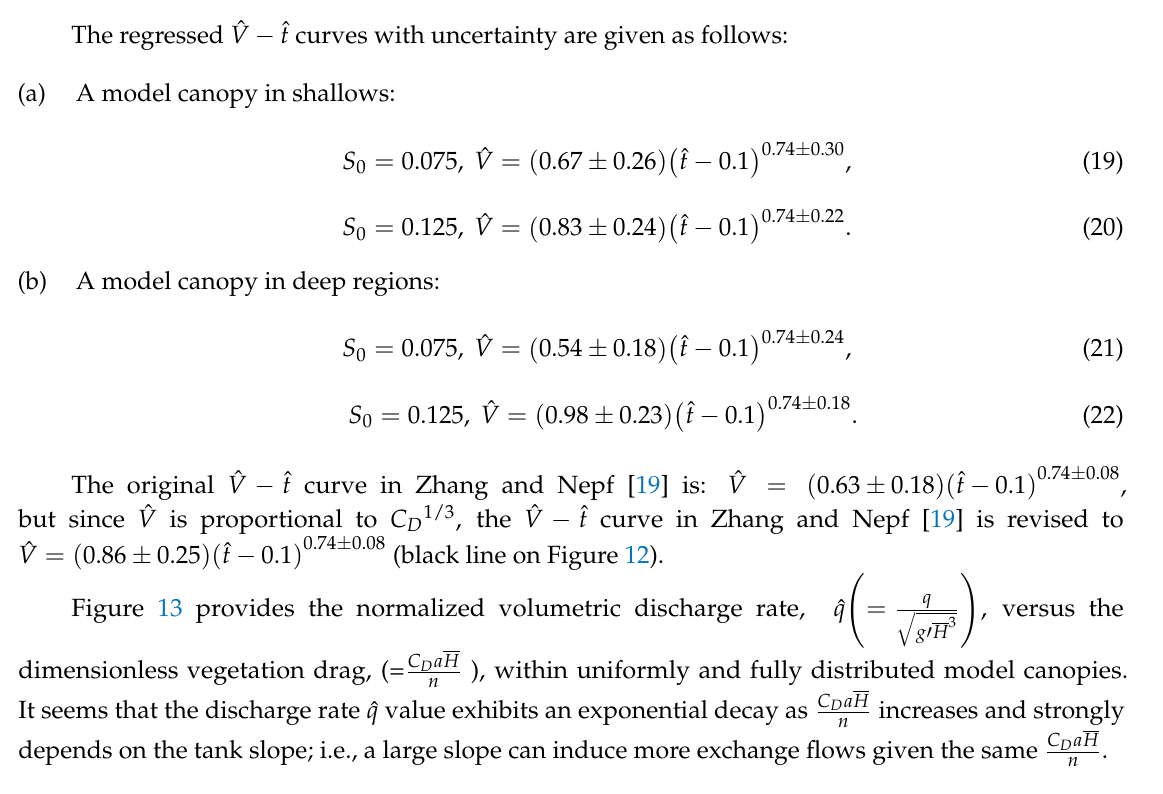
Figure 12. Temporal variation in the total volume discharge per unit width: ( a ) vegetation distributed in shallows and ( b ) vegetation distributed in deep regions.